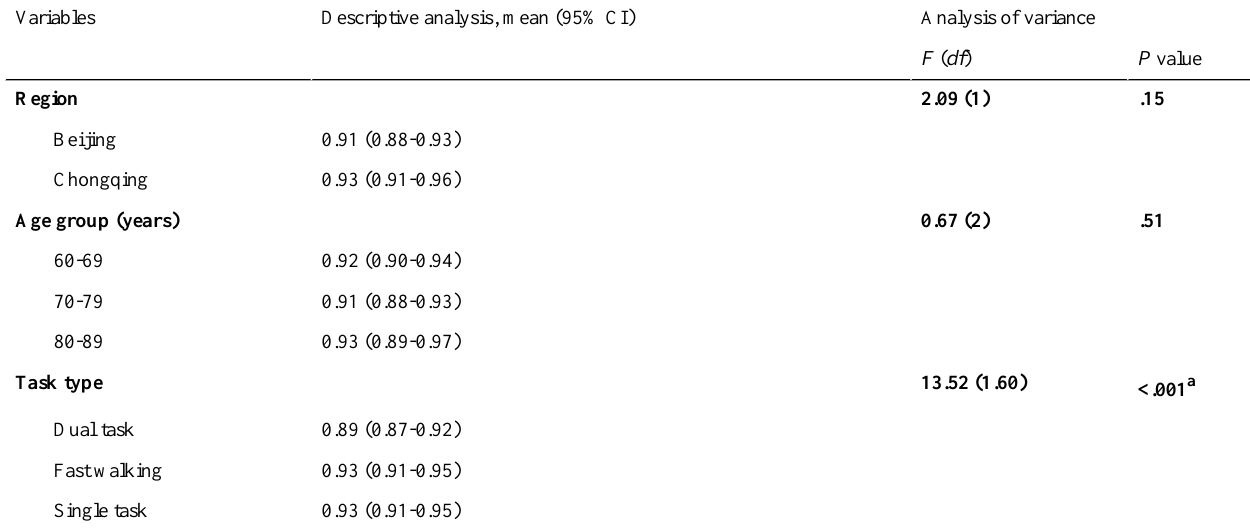
Table 6. Statistics for step symmetry.